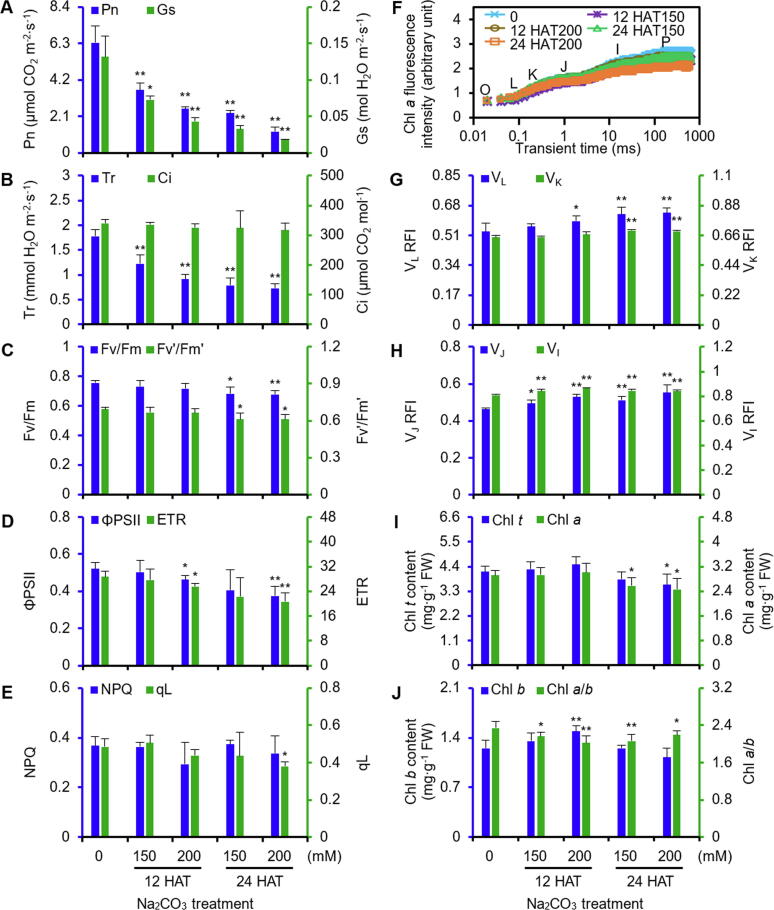
Photosynthetic characteristics of alkaligrass under Na2CO3 treatmentA. Net photosynthetic rate (Pn) and stomatal conductance (Gs). B. Transpiration rate (Tr) and intercellular CO2 concentration (Ci). C. Maximum quantum efficiency of PSII photochemistry (Fv/Fm) and PSII maximum efficiency (Fv′/Fm′). D. Actual PSII efficiency (φPSII) and electron transport rate (ETR). E. Non-photochemical quenching (NPQ) and the fraction of open PSII centers (qL). F. Chlorophyll fluorescence OJIP transient. Fluorescence intensity (Ft) was recorded between 0.01 and 1000 ms time period. G. Relative fluorescence intensity (RFI) of band L (VL) and K (VK) after double normalization between the two fluorescence extreme FO and FK, FO and FJ phases: VL = (FL − FO)/(FK − FO), VK = (FK − FO)/(FJ − FO). H. Relative fluorescence intensity (RFI) of step J (VJ) and I (VI) after double normalization between the two fluorescence extreme FO and FP phases: VJ = (FJ − FO)/(FP − FO), VI = (FI − FO)/(FP − FO). I. Total chlorophyll (Chl t) and chlorophyll a (Chl a) contents. J. Chlorophyll b (Chl b) content and chlorophyll a/b (Chl a/b) ratio. The values were determined after plants were treated with 0, 150, or 200 mM Na2CO3 for 12 or 24 h (12 HAT150, 12 HAT200, 24 HAT150, and 24 HAT200), and were presented as means ± S.D. (n ≥ 3). The asterisks indicate significant differences (Student's t test, *, P < 0.05; **, P < 0.01).